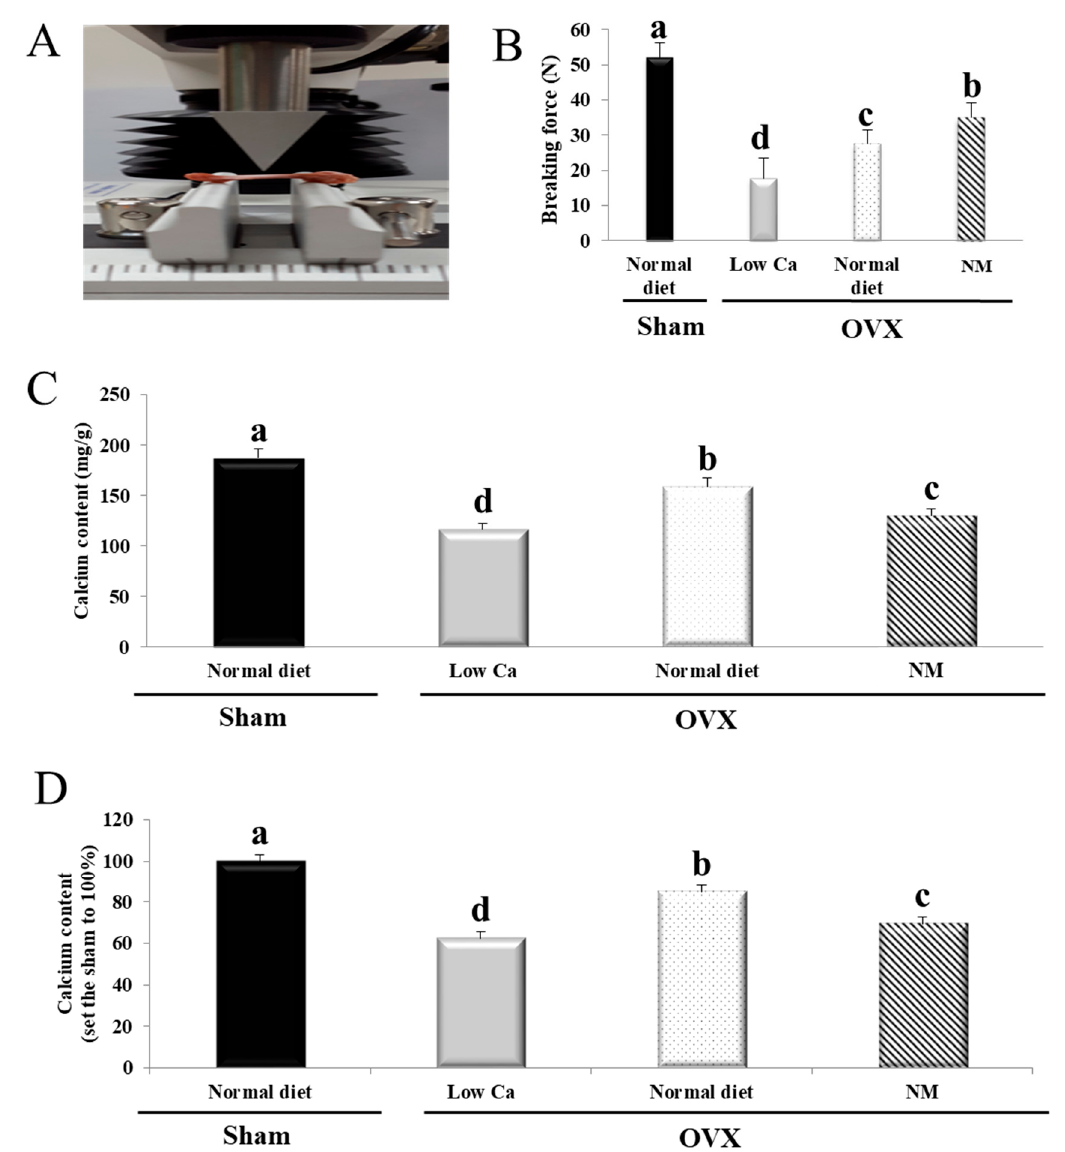
Figure 4. Breaking force graph for the rat tibia. ( A ) Details of the breaking force measurement by texture analysis. ( B ) Breaking force required for rat tibias. ( C ) Tibial Ca levels in the indicated rats. ( D ) The value of the tibial Ca levels when sham was set to 100%. Results are expressed as the mean ± SD. Values not sharing a common superscript ( a – c ) di ff ered significantly (Duncan’s multiple range test) ( p <